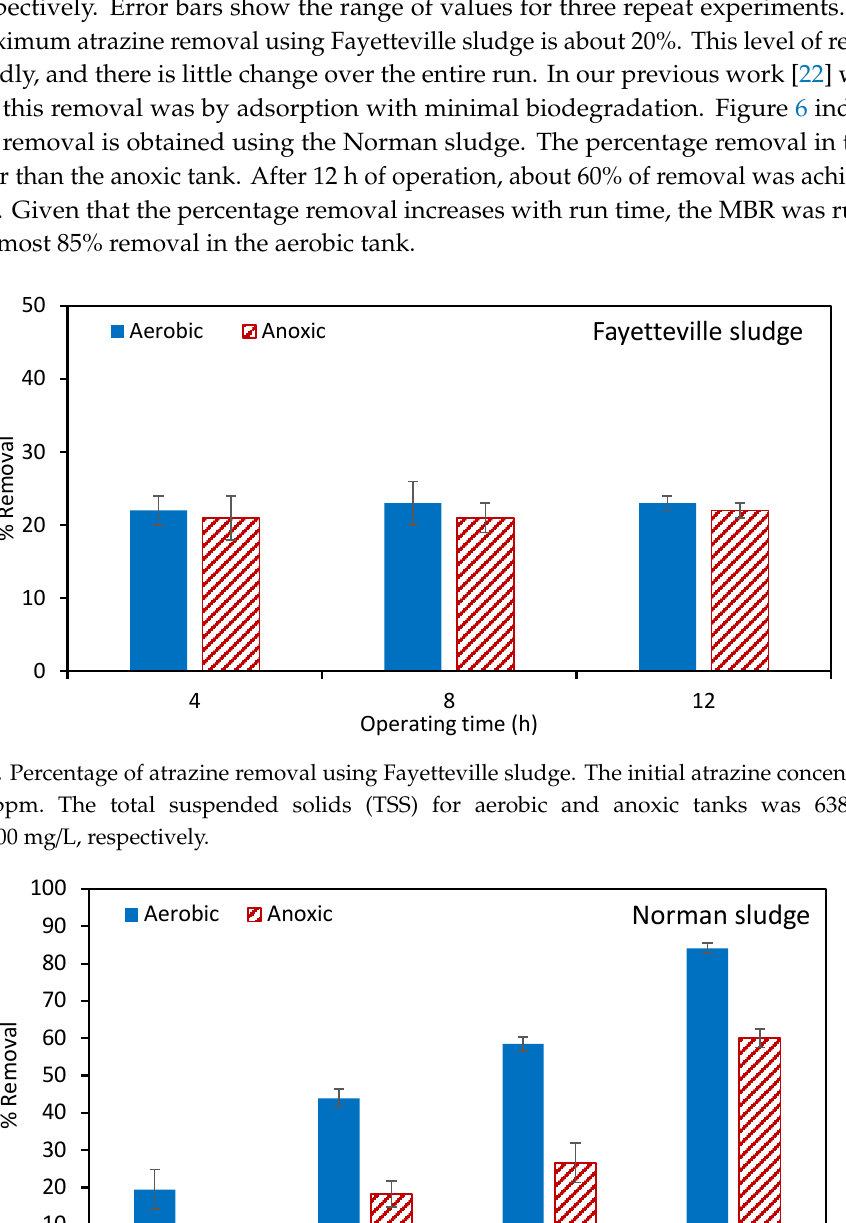
Figure 7. Percentage removal of atrazine in batch experiments where there is no mixing of the MLSS using Fayetteville sludge. The total suspended solids (TSS) in aerobic and anoxic tanks was 5958 and 4920 ± 600 mg/L, respectively.